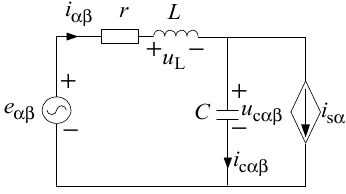
Figure 8. AC equivalent circuit